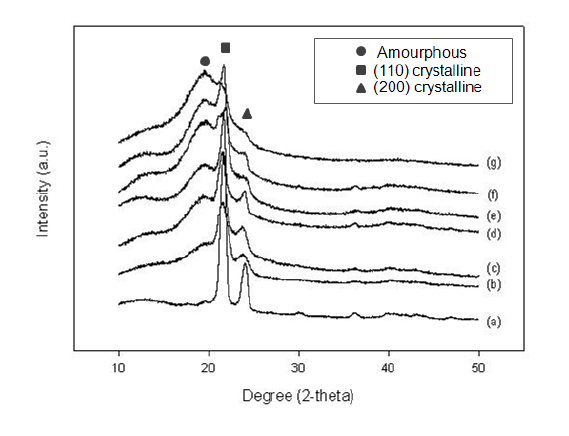
Figure 3. X-ray diffractograms of different samples. From bottom to top. (a) homopolymer (b) ethylene/1-C and (g) ethylene/1-C